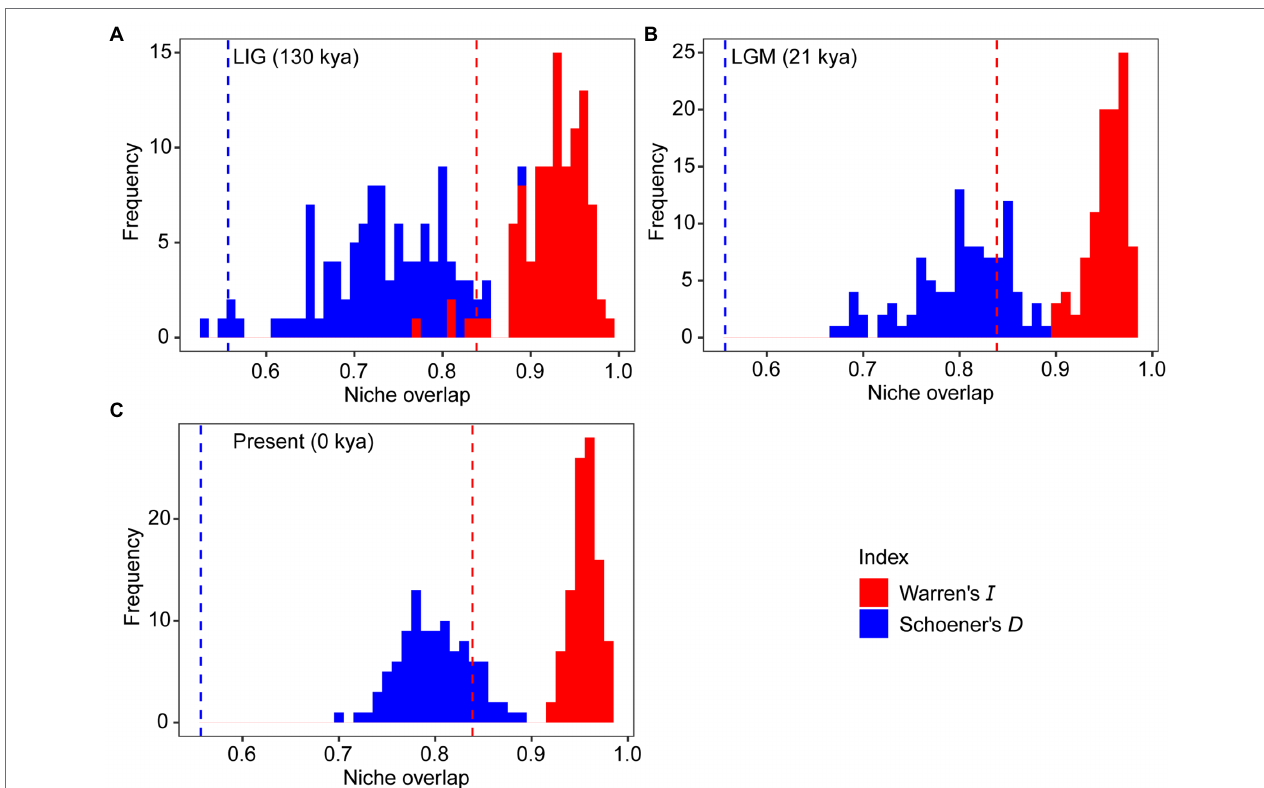
FIGURE 3 | Niche divergence between the western and eastern groups of Toxicodendron vernicifluum during the Last Interglacial (LIG; A ), Last Glacial Maximum (LGM; B ), and present (C) . The niche identity test was conducted to quantify niche overlap using two indices, Warren’s I (red) and Schoener’s D (blue). Vertical lines and histograms represent the observed values and null distributions (based on 100 pseudoreplicates) of niche overlap statistics, respectively.